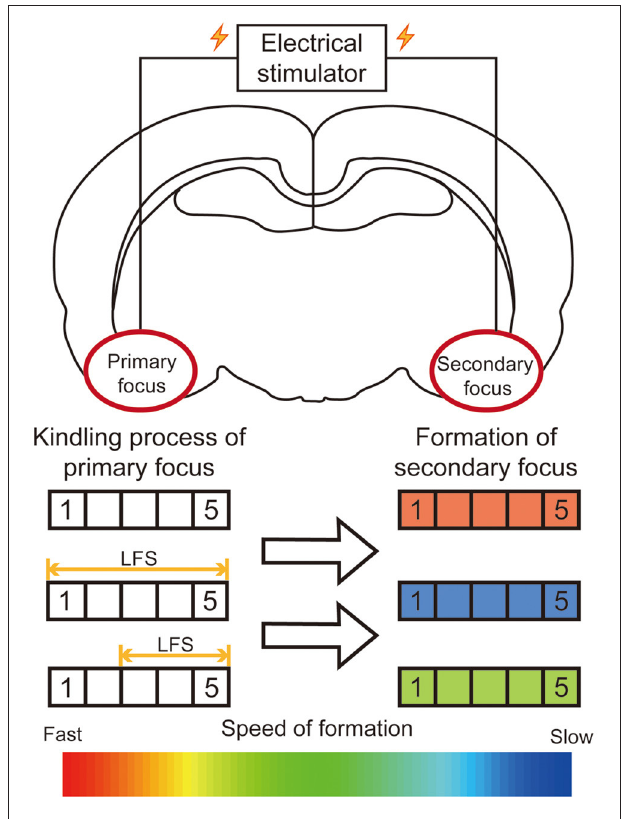
FIGURE 3 | Summary diagram of efficacy of LFS on the primary focus for secondary epileptogenesis. In the kindling model of secondary epileptogenesis, bilateral amygdalae were kindled successively. The application of LFS at the primary focus significantly retards the epileptogenesis of the secondary focus. The rectangle on the left represents the stage to which the primary focus was kindled. The color of the rectangle on the right represents the relative speed of the formation of the secondary